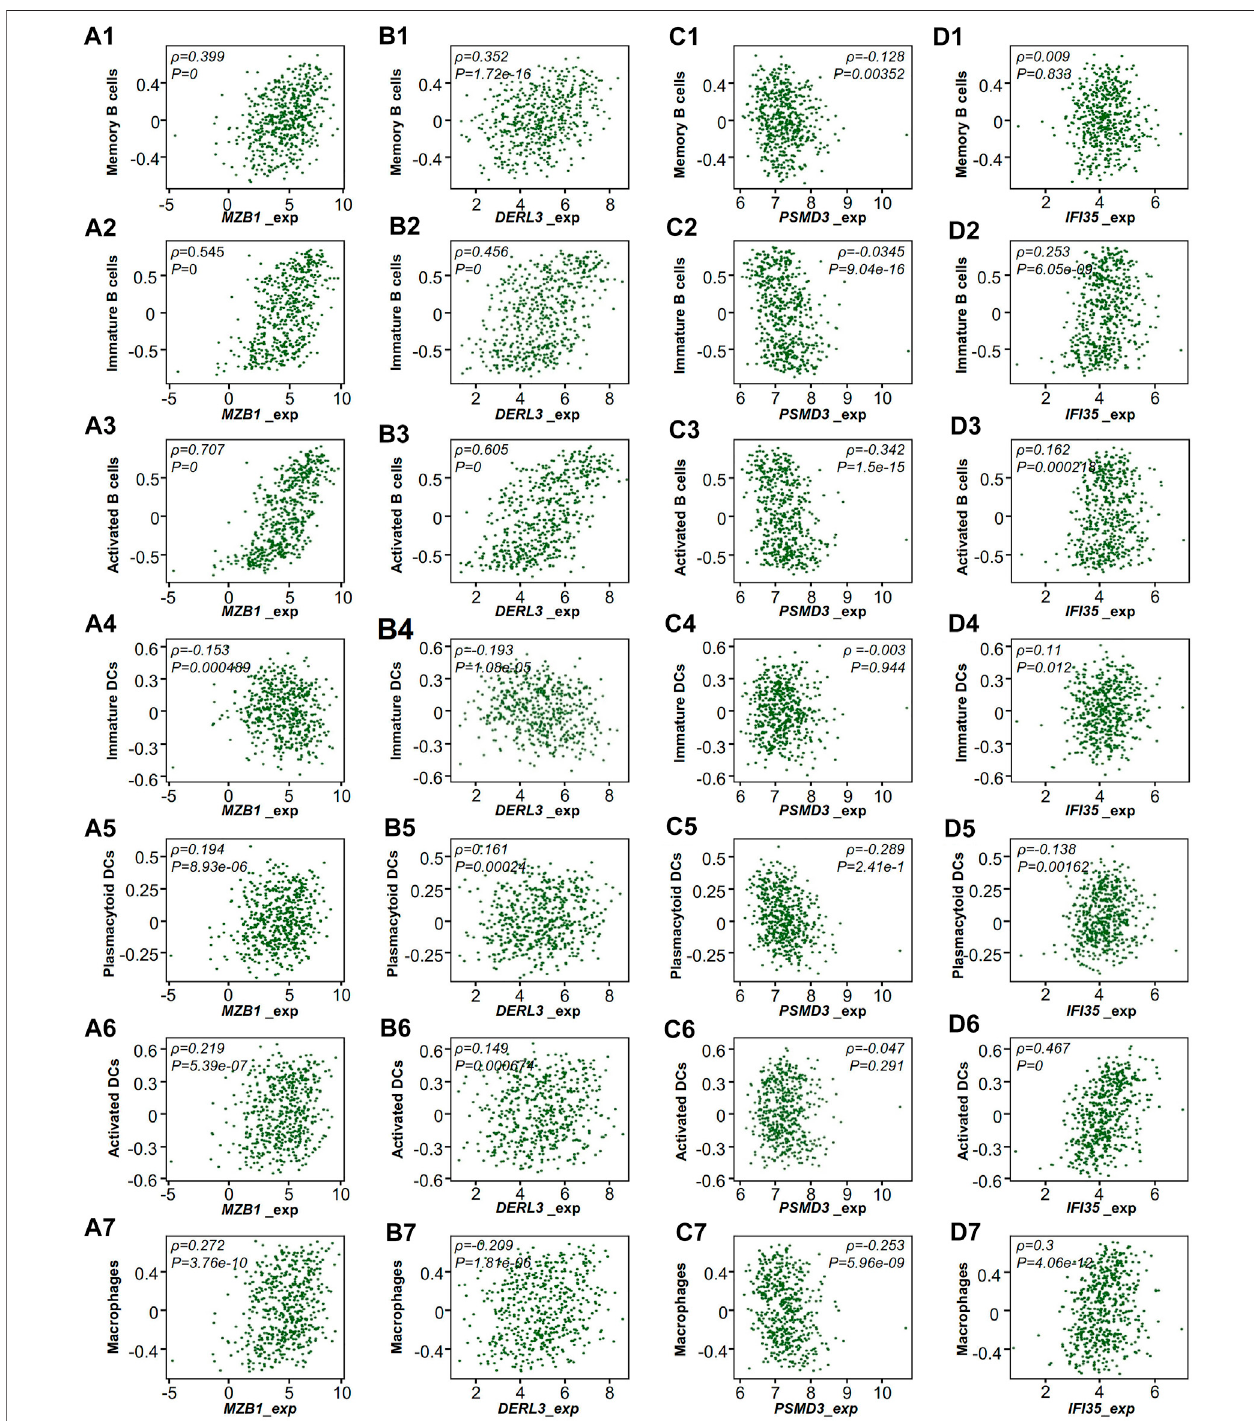
FIGURE6| TCGA-LUADmicroenvironment ofRT-treated patients.Correlationoftheexpression ofhubgeneswiththein fi ltrationofimmunecellsfrom TISIDB. (A) MZB1, (B) DERL3, (C) PSMD3, (D) IFI35. Each dot represents a sample in the TCGA-LUAD dataset. ρ , Spearman correlation coef fi cient.